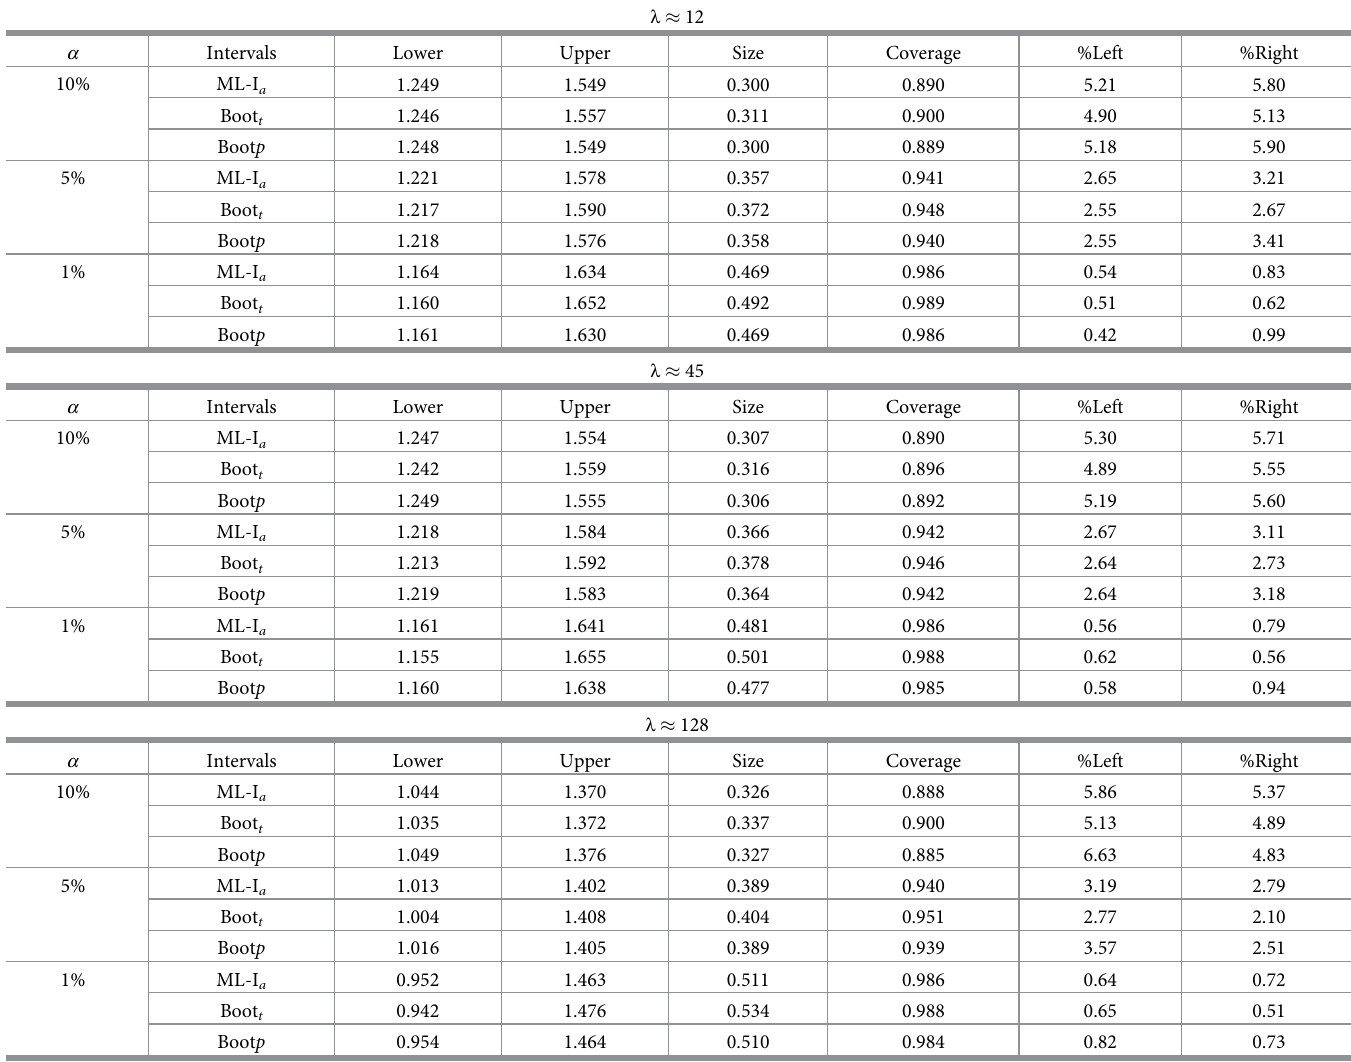
= 1 (cid:0) μ Þ ¼ β þ x β 2 þ β þ β and log ð σ 2 Þ ¼ γ þ z γ 2 , t = 1, ... , n , μ t 2 (0.02, 0.32), β 2 = 1.2, n = x x t t 2 t t 1 3 t 3 4 t 4 1 t